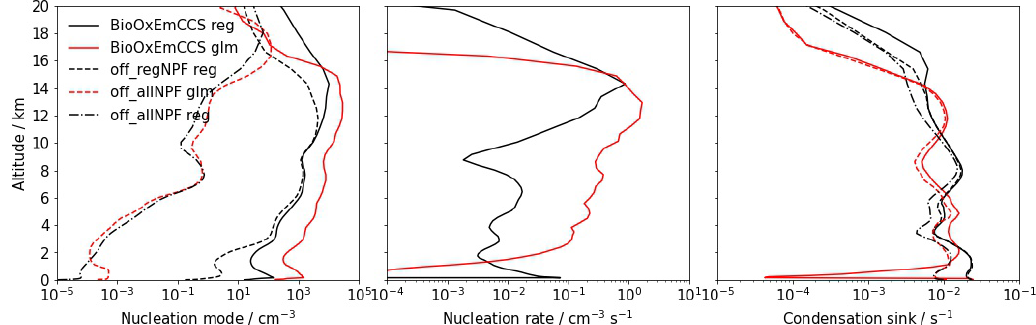
Figure A3. The regional domain-averaged profiles of nucleation mode aerosol number concentrations, nucleation rate and condensation sink from the simulations BioOxEmCCS (solid), off_allNPF (dotted dashed) and off_regNPF (dashed) in the global model (red) and regional model (black).